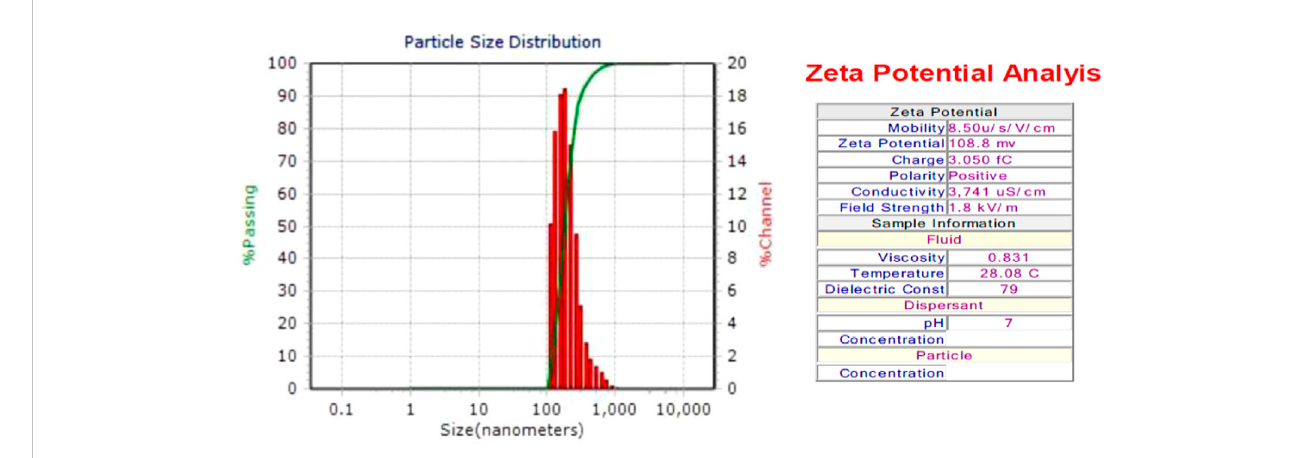
FIGURE 7 DLS measurement of as-prepared SOR-AgNPs.